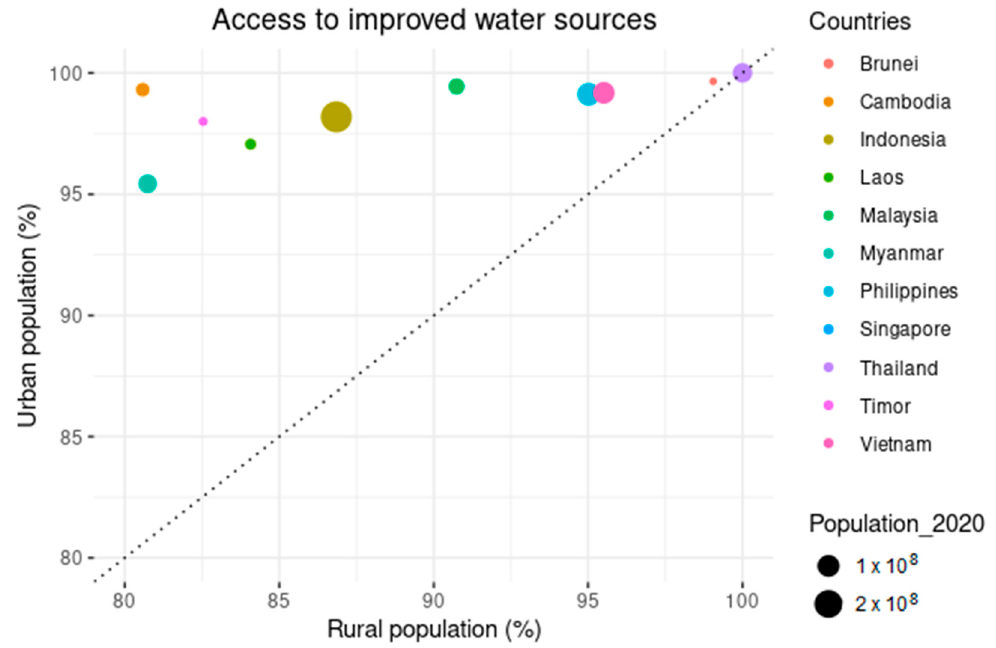
Figure 2. Percentage of Southeast Asian urban and rural populations with access to improved water sources in 2020 (excluding Singapore as it has zero rural population). [dataset] WHO/UNICEF Joint Monitoring Program (JMP). 2021. Data: Households.